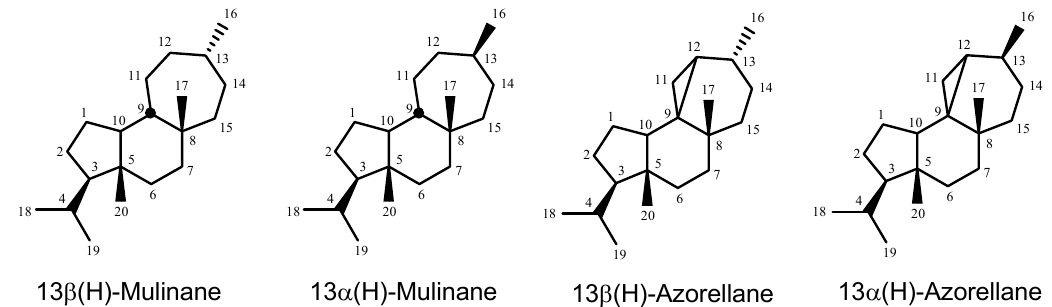
Figure 1. Carbon numbering convention for the mulinane and azorellane skeletons.